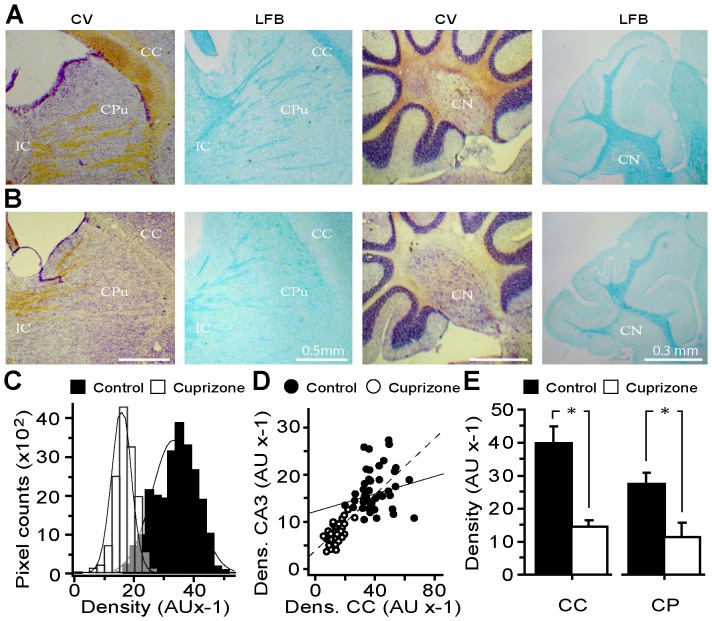
Cuprizone administration to mice induces widespread demyelination in several brain structures and reduces the myelin content.(A–B) Representative light micrographs of sagittal sections of brain from control and cuprizone-treated mice, respectively, stained for myelin with CV and LFB dyes. (A) Myelin is visualised in samples from the control mice, as light brown by CV and dense blue for LFB, in corpus callosum (CC), the stripes in the corpus striatum of the caudate putamen (CPu), internal capsule (IC) and the central nuclei of the cerebellar medulla (CN). (B) Extensive demyelination was observed in the above regions of treated mice. (C) Plot of the density distribution of myelin stained with LFB of defined colossal ROIs. A narrow and leftward-shift in the histogram of the density of myelin in cuprizone-treated samples reflects callosal demyelination (n = 6 in each group). (D) Correlation analysis of the density of LFB-stained myelin of random ROIs from callosal and hippocampal CA3 areas. Note the higher level of callosal myelin in controls (R2 = 0.21) compared to CA3 area, with its stronger decline in experimental samples (R2 = 0.54). (E) Summary histogram of the mean myelin density in CC and CP regions (>100 ROIs, from each group) with both areas revealing significant loss of myelin in mice that had received cuprizone. * p<0.05.